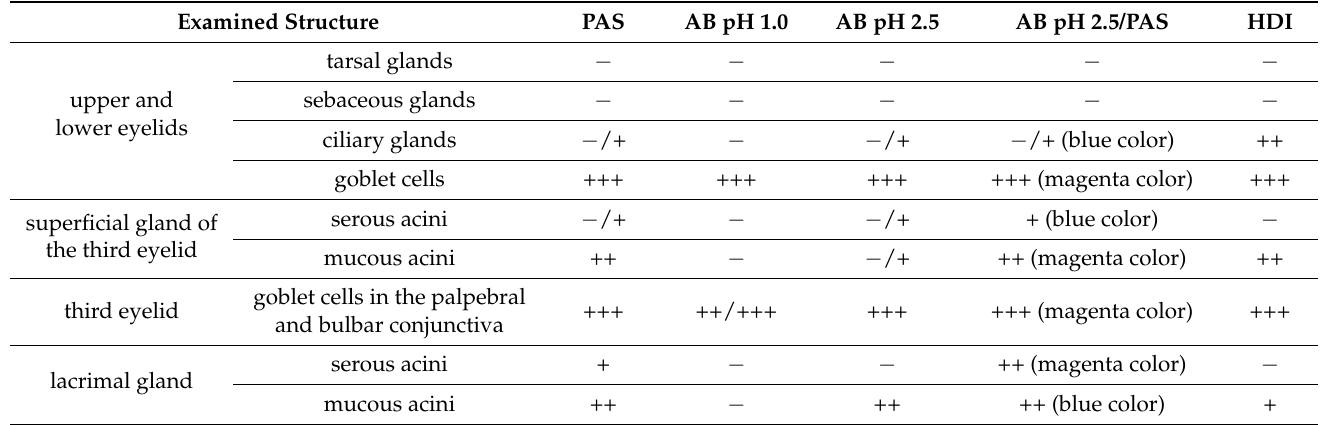
Table 1. Histochemical analysis of the Ursus thibetanus upper and lower eyelids, superficial gland of the third eyelid, third eyelid and lacrimal